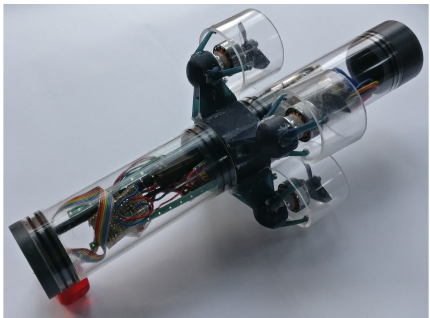
Figure 1. Micro underwater robot HippoCampus for environmental field